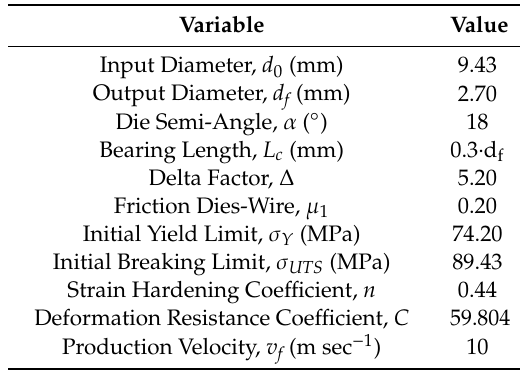
Table 6. Input variables in the multi-stage wiredrawing process.